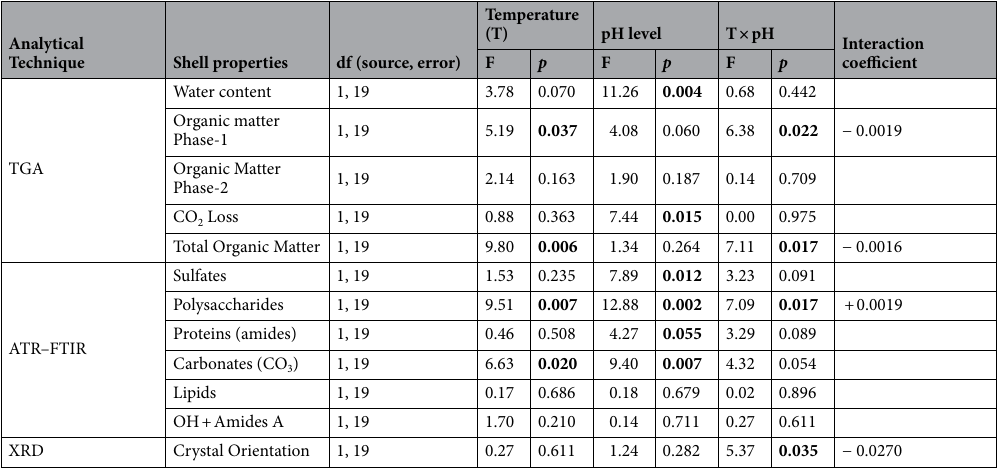
Table 2. Summary results (2-way ANOVA) for shell mineral (TGA) and periostracum (ATR-FTIR) organic composition, and crystal orientation (XRD). These properties were measured at the growing shell edge of Argopecten purpuratus scallops. F and p are F-ratio and p -values, respectively. Significant p -values ( p < 0.05) are shown in bold. The coefficient identifies antagonistic (−) and synergistic (+) effects in the interaction of both environmental variables.